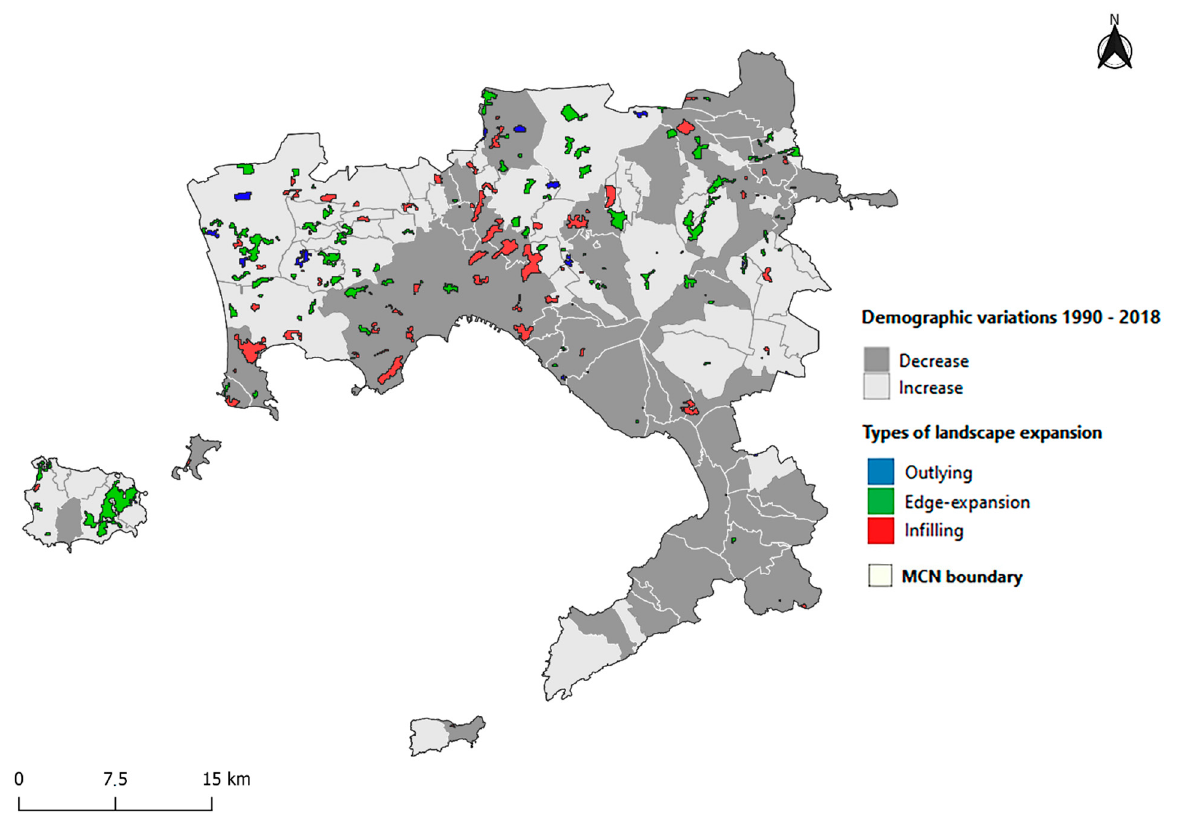
Figure 6. Map showing the demographic variation and type of landscape-fragmentation trend over time (1990–2018) in the MCN.